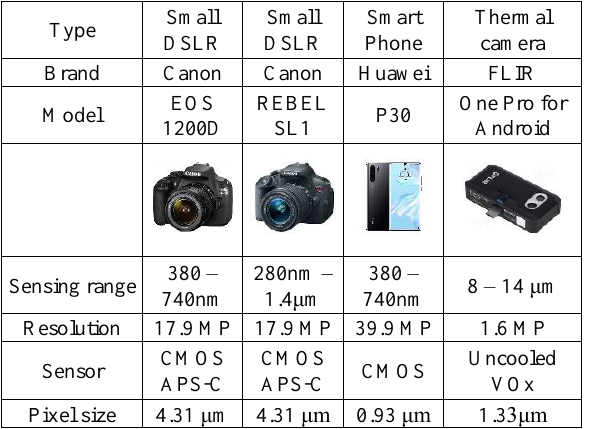
Table 1: employed imaging sensors